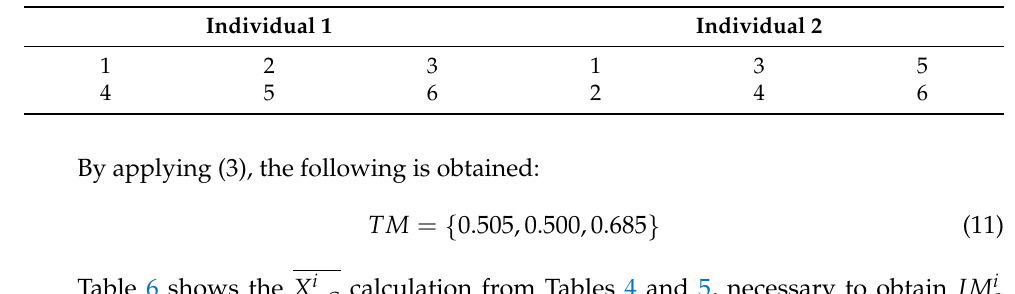
Table 5. Two possible example